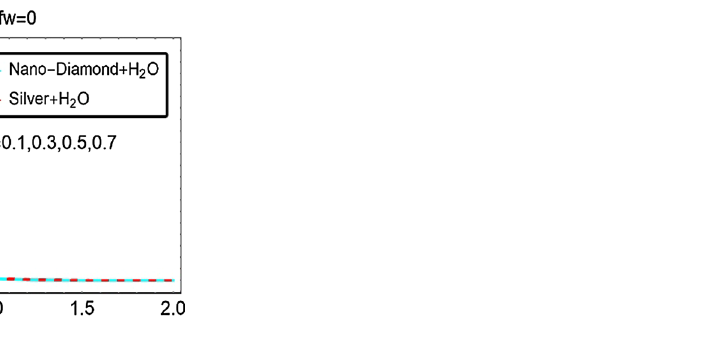
0 for varying A =